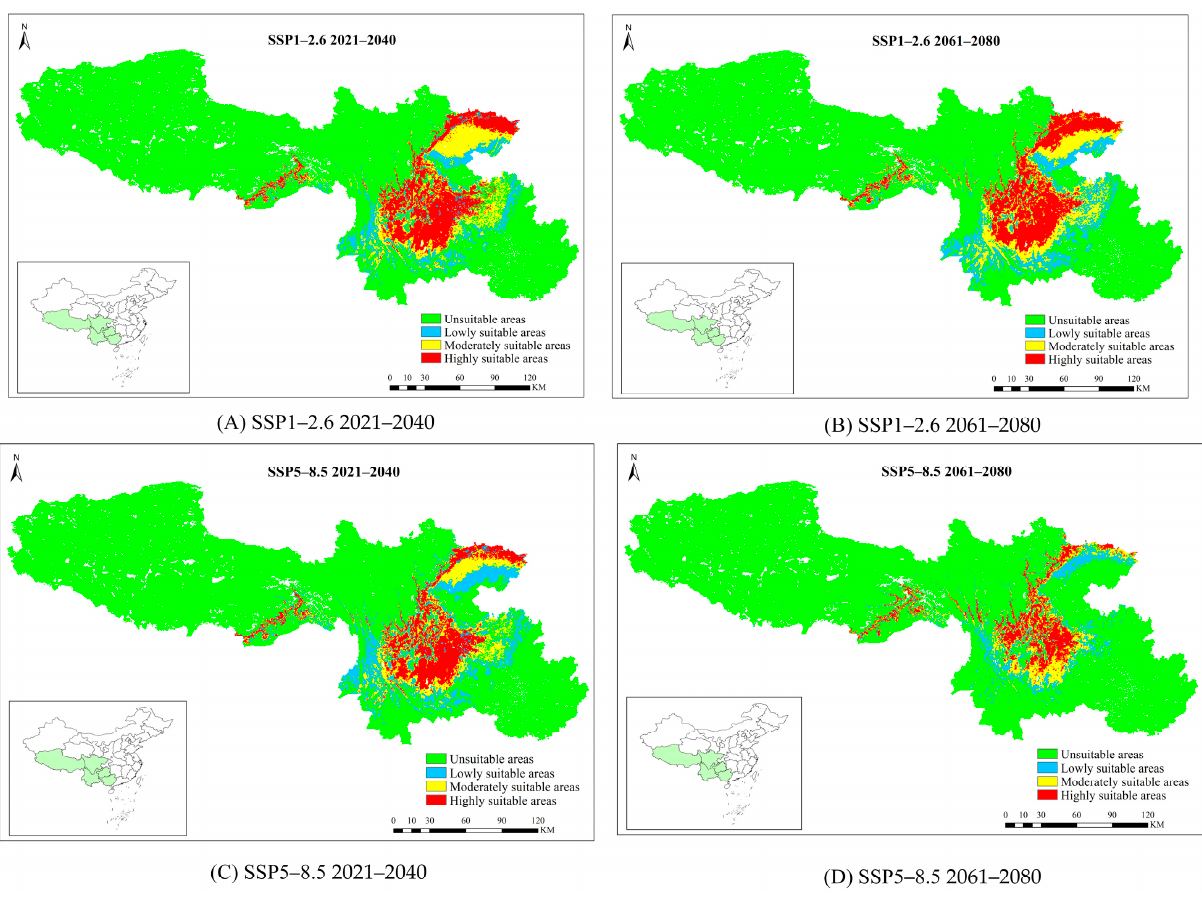
Figure 7. The future potential distribution of T. yunnanensis under different climate scenarios.